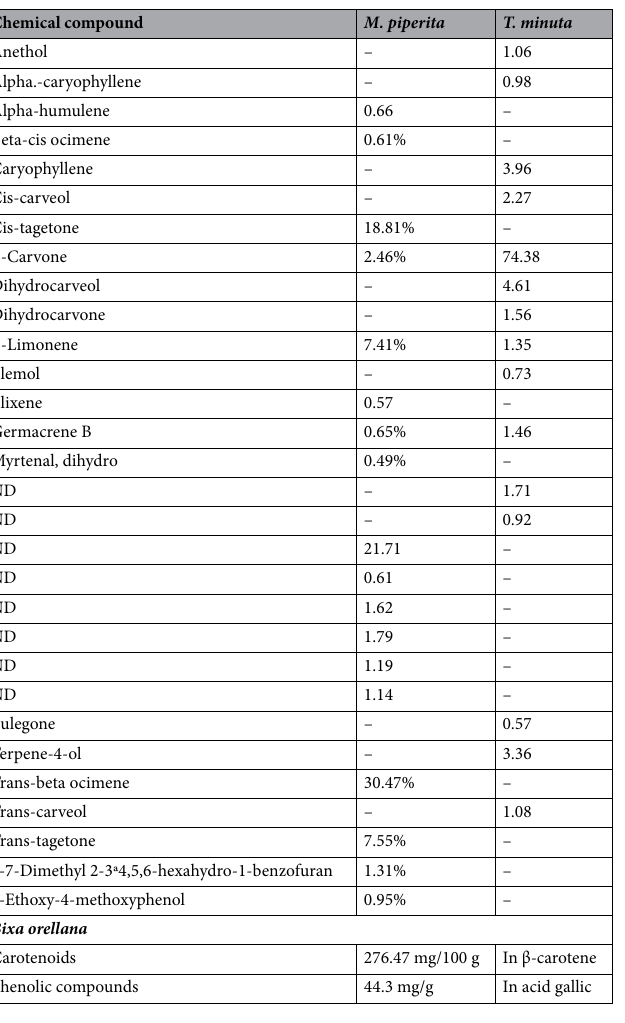
Table 2. Identification of the compounds (%) of the essential oils of M. piperita and T. minuta, and crude ethanolic tincture of B. orellana. ND not identified.